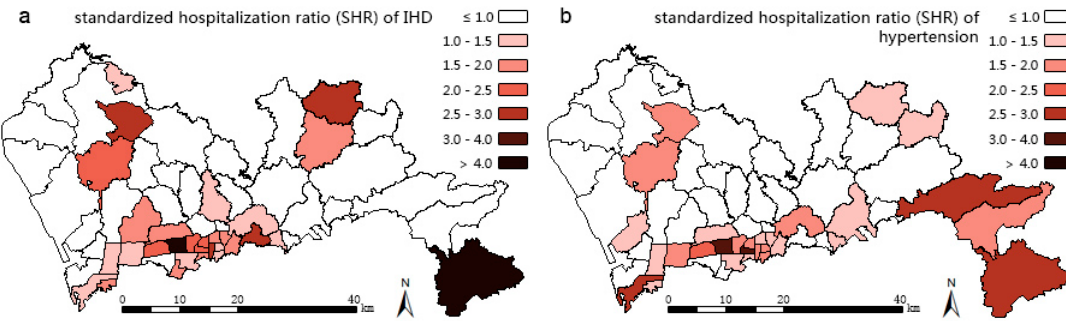
Figure 3. Spatial patterns of standardized hospitalization ratios (SHRs) of ( a ) Ischemic Heart Disease (IHD); ( b ) hypertension in 2012 for Shenzhen at the sub-district level.